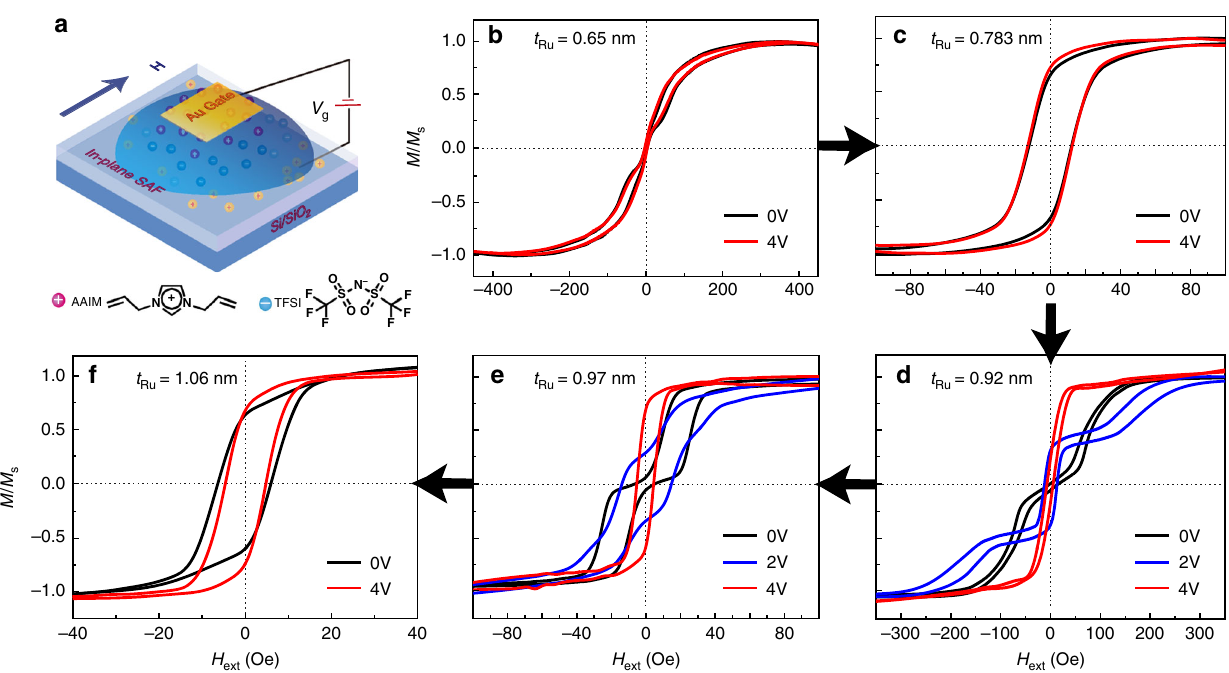
Fig. 2 Controllable magnetic hysteresis loops switching by IL gating for in-plane FeCoB/Ru/FeCoB/SiO 2 /Si SAF heterostructures. a Schematic of IL gating magnetism modi fi cation process. b – f are in-situ VSM test of all samples while under IL gating modi fi cation. The black curves, blue curves, and red curves illustrate the ungated fi lms, the fi lms gated at 2 V, 4 V, respectively. The applying magnetic fi eld was along easy axis